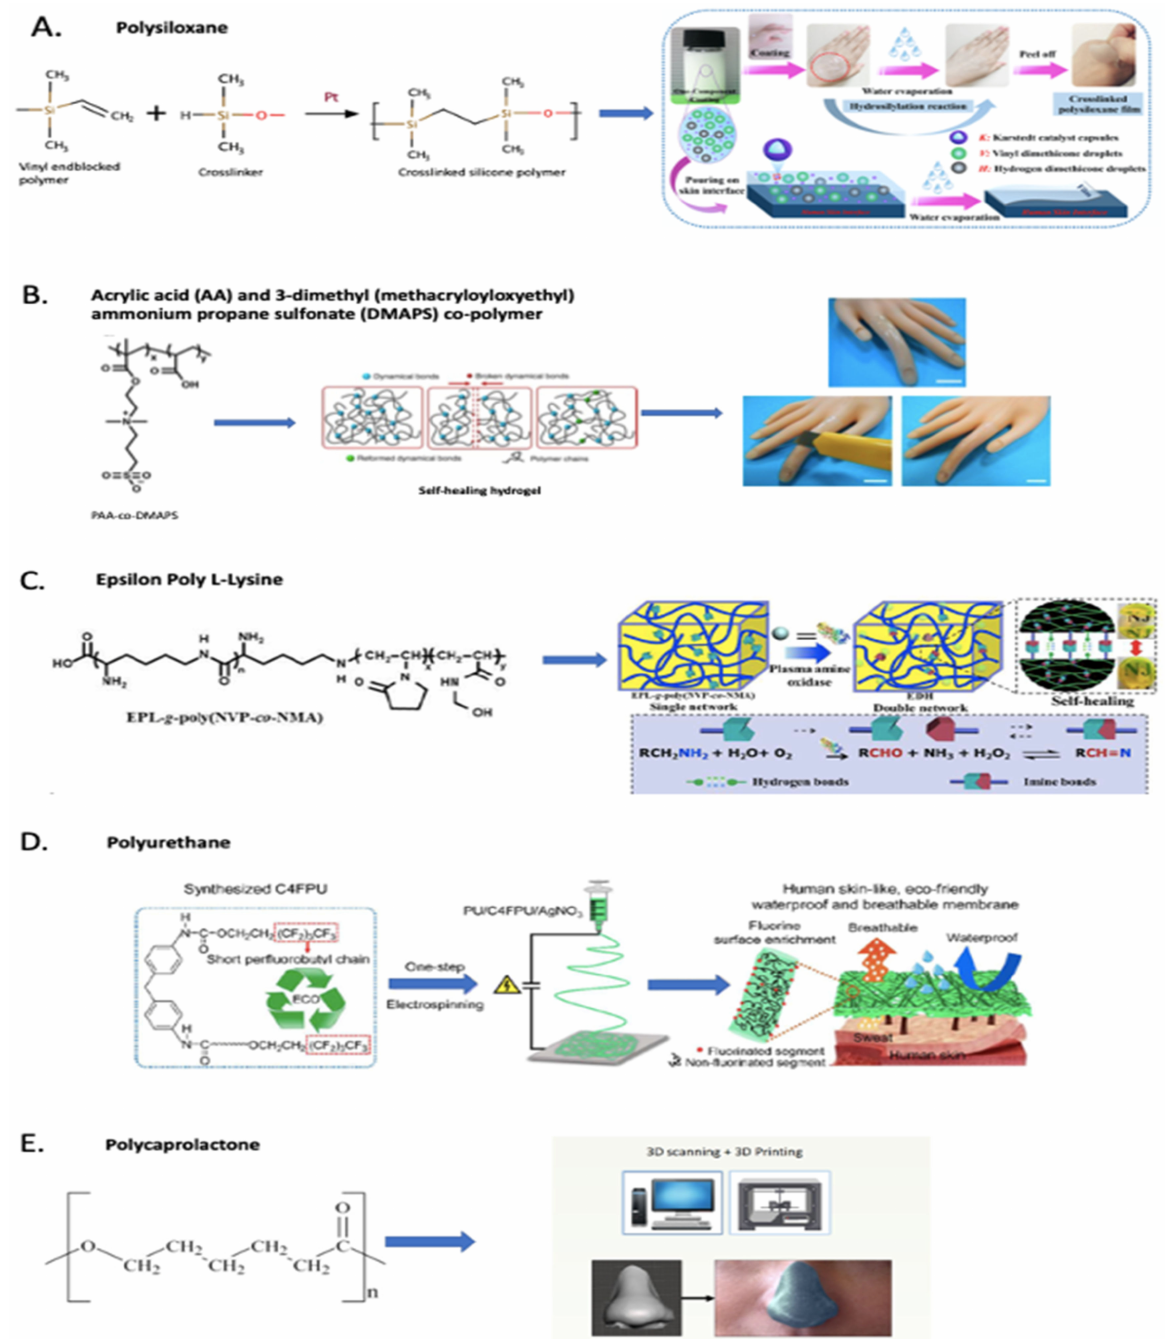
Figure 2. Examples of synthetic polymer formulation strategies: ( A ) Polysiloxane-based formulation for second skin [125,127]; ( B ) Acrylic acid (AA) and 3-dimethyl (methacryloyloxyethyl) ammonium propane sulfonate (DMAPS) co-polymer-based self-healing hydrogel [135]; ( C ) Epsilon Poly L -Lysine-based self-healing hydrogel [136]; ( D ) Polyurethane (with short perfluorobutyl chain) waterproof and breathable membrane [137]; ( E ) Polycaprolactone-based skin-conformable 3D-printed wound dressing